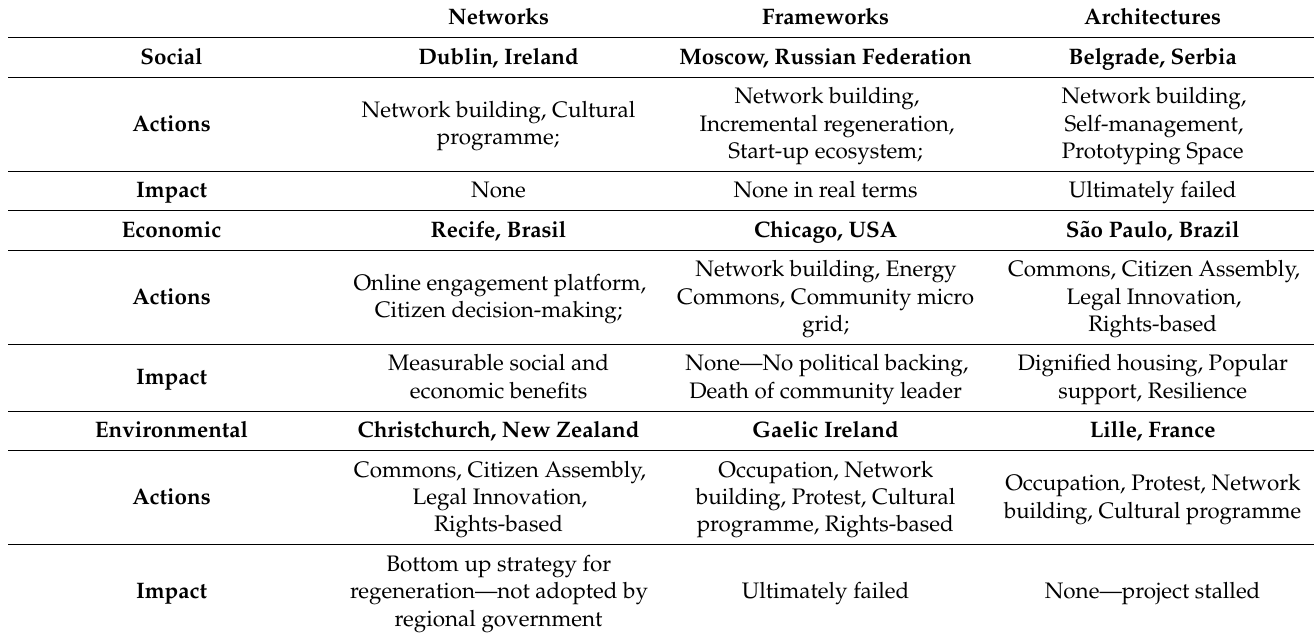
Table 3. Research findings from case